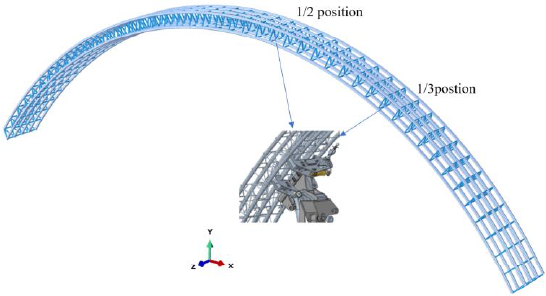
Figure 17. Calculation model of prefabricated spatial reticulated grid.